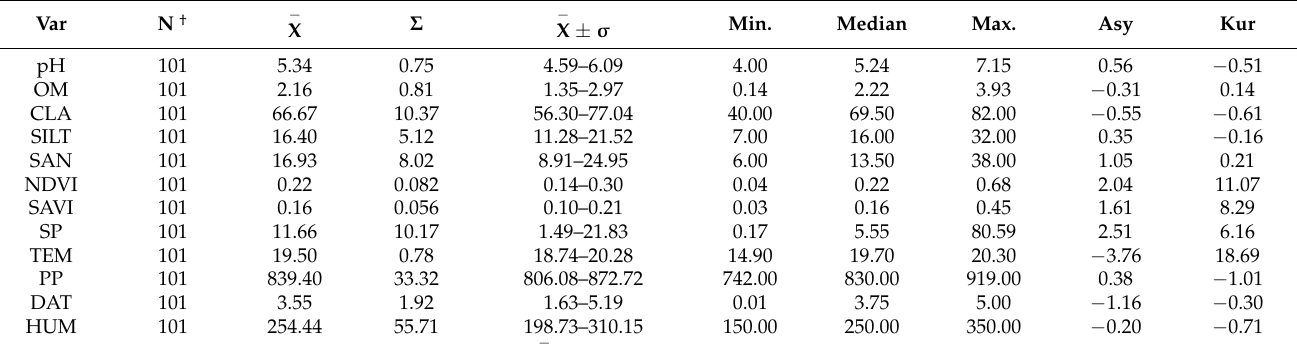
Table 1. Descriptive statistics of the environmental variables of the soil-forming factors.